Question: Which kind of chart has been used to present this data?
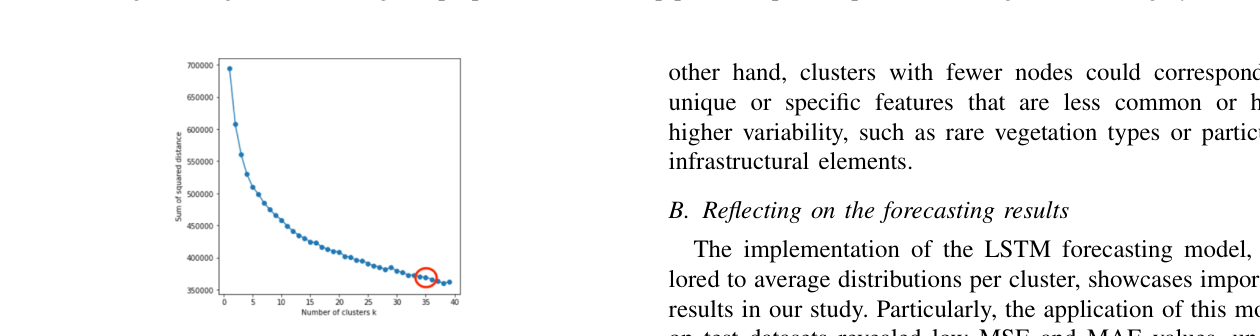
Answer: line